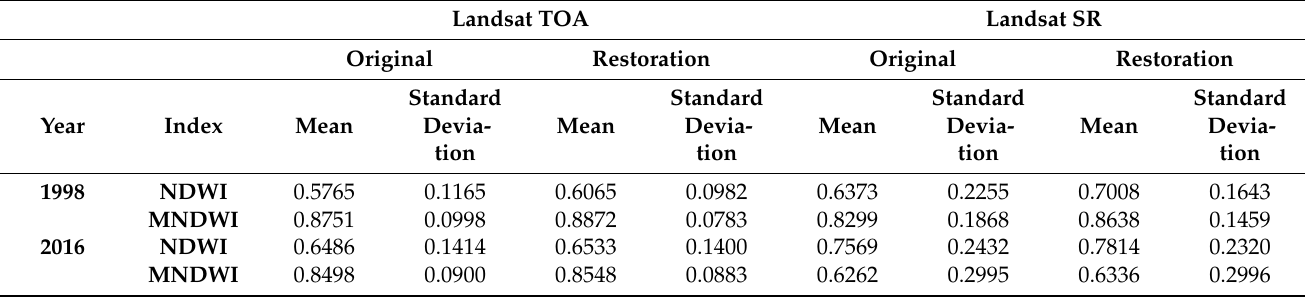
Table 2. Mean values and standard deviations of NDWI and MNDWI of Landsat TOA and SR.